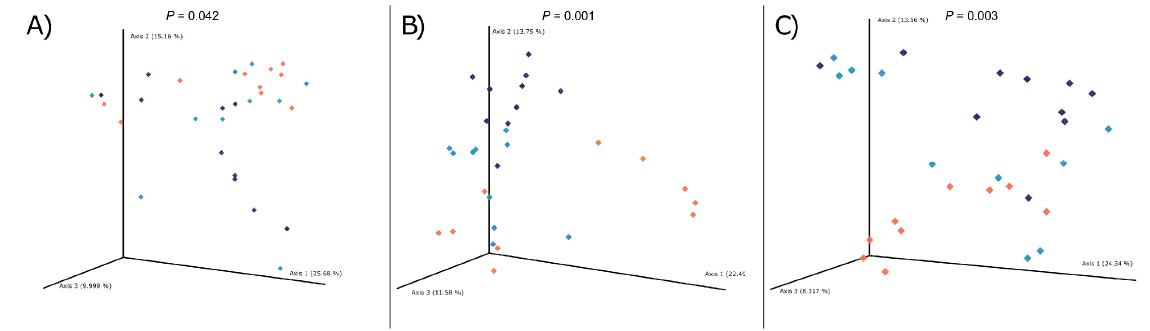
Figure 4. Beta diversity (Bray–Curtis dissimilarity plots) of fecal microbial populations in pigs inoculated with Brachyspira hyodysenteriae and fed a lowly fermentable diet (orange; LFF), an intermediate fermentability diet (turquoise; MFF), and a highly fermentable diet (navy blue; HFF) at days post inoculation ( A ) 0, ( B ) 12, or ( C )